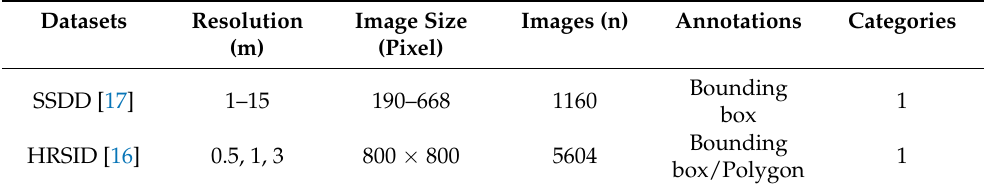
Table 3. Statistics of two SAR ship detection datasets.